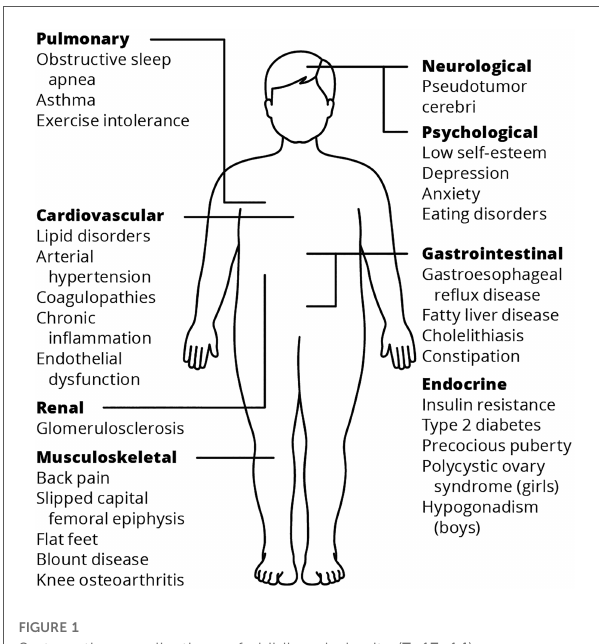
FIGURE 1 Systematic complications of childhood obesity ( 7 , 13 , 14